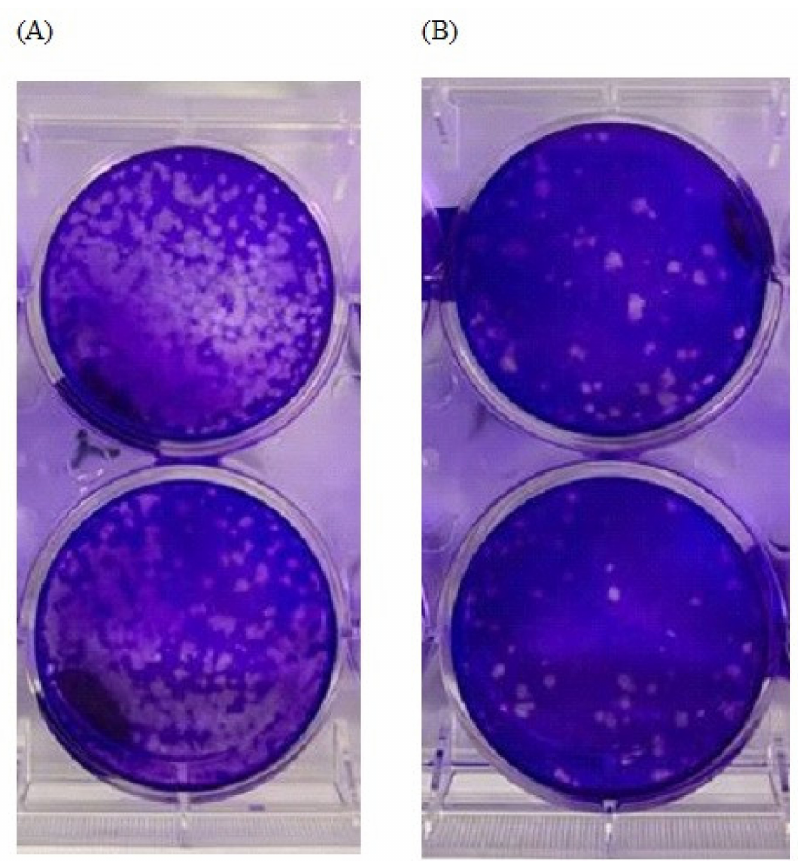
Figure A1. Plaque assay of Tulane virus on chicken salad without ( A ) and with ( B ) atmospheric dielectric barrier discharge cold plasma